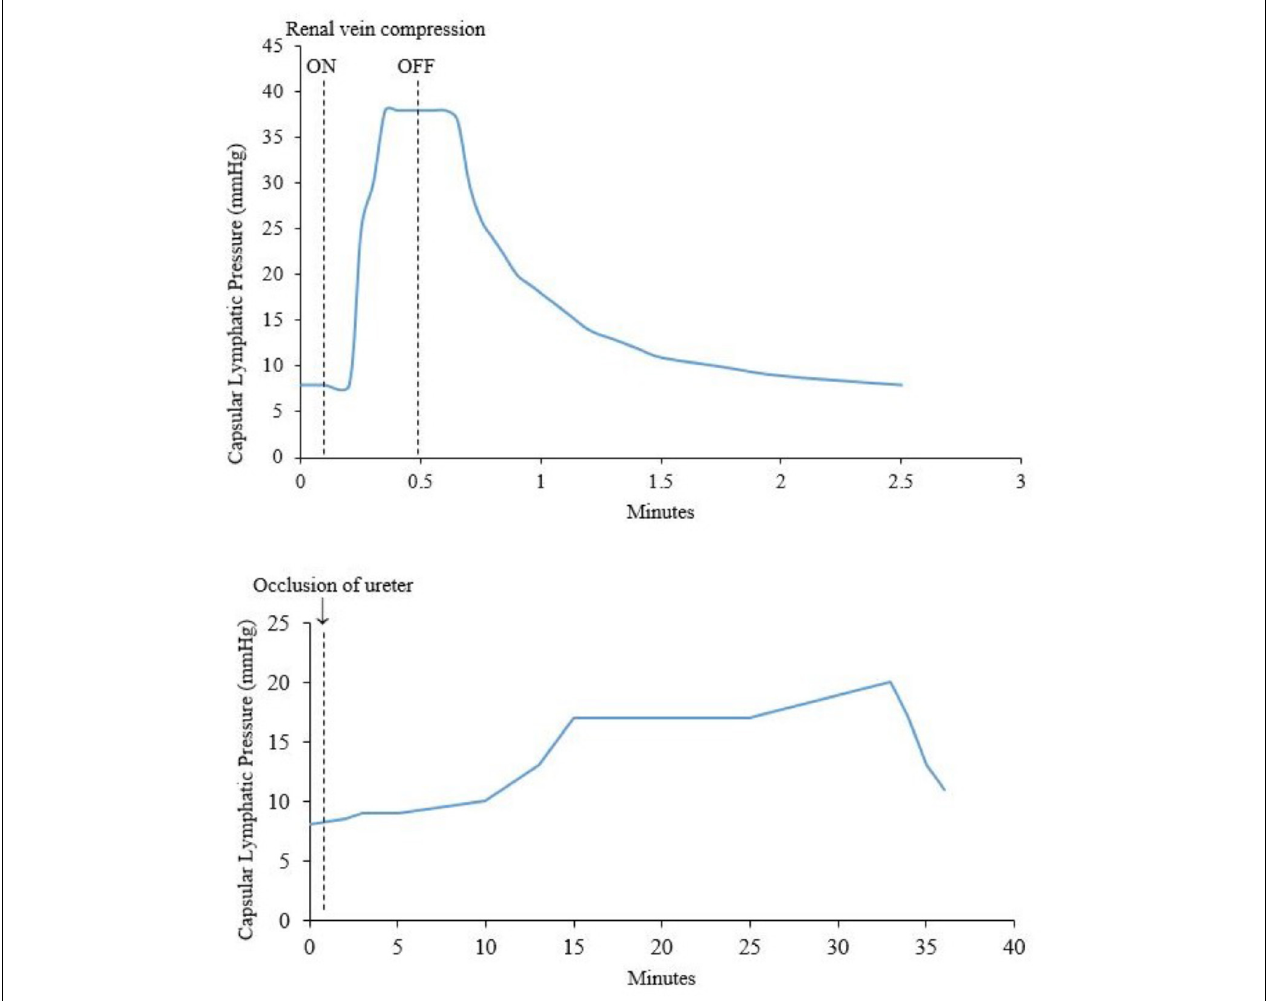
FIGURE 4 | (Top) Effect of compression of the renal vein on renal capsular lymphatic pressure in a dog. Note that the rise in pressure occurs 5 s after compression of the renal vein. (Bottom) Effect of occlusion of the ureter on capsular lymphatic pressure in a dog. The ureter remained clamped throughout the time period of the graph. The sudden drop in pressure around 33 min was seen when the kidney was very tense and is presumably from occlusion of the lymphatic vessels at the point where they exit the kidney. Adapted with permission from Katz (1958).